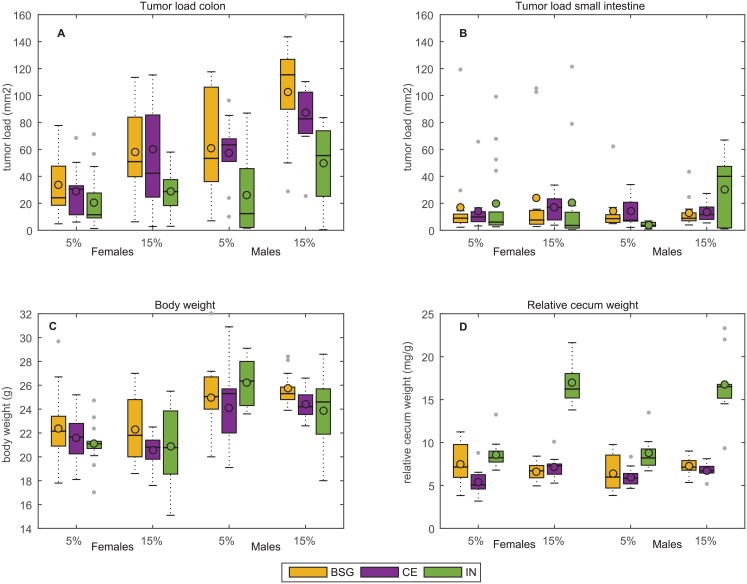
Boxplot showing differences between intervention groups.(A) Tumorigenesis in colon. (B) Tumorigenesis in small intestine. (C) Body weight. (D) Relative cecum weight. The fibers were tested at two concentrations (5% and 15%) in female and male A/J Min/+ mice treated with AOM. The * represents outliers (more/less than 3/2 times of the upper/lower quartile).